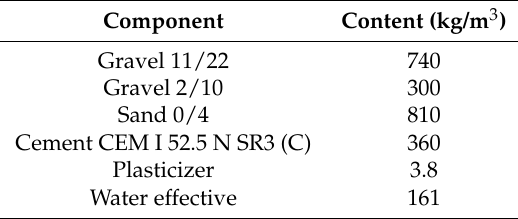
Table 1. Composition of concrete